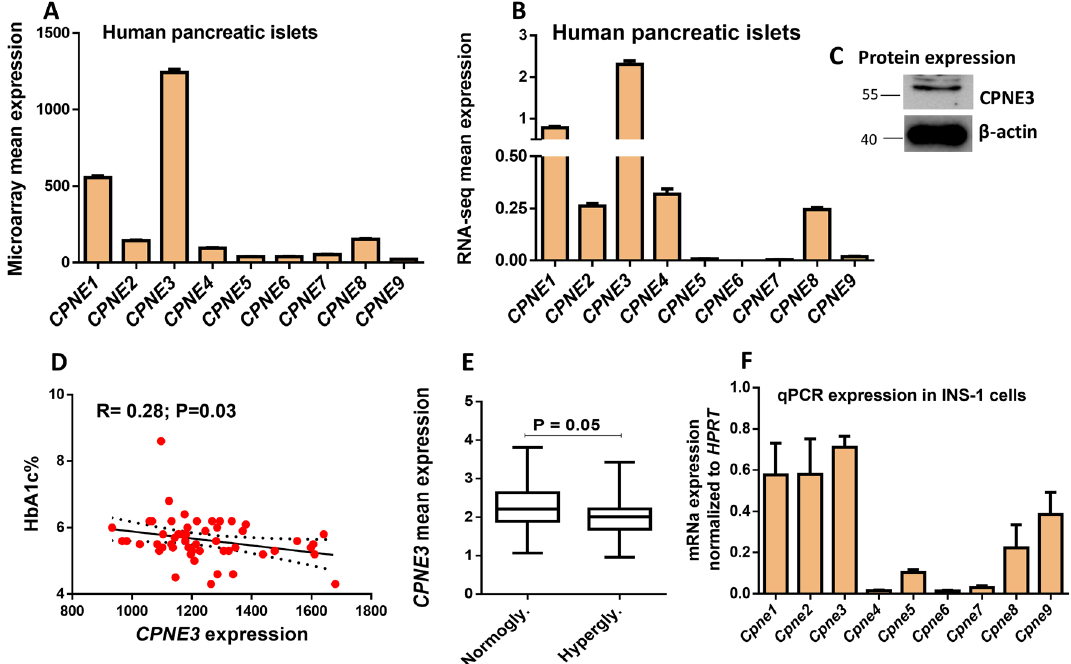
Figure 1. Expression profile of copine genes in human pancreatic islets. ( A ) Microarray mean expression of the nine copine genes in nondiabetic human islets ( n = 67). ( B ) RNA sequencing expression of copine genes in nondiabetic human islets ( n = 67). ( C ) Western blot expression of CPNE3 obtained from nondiabetic human islets (n = 1; obtained from Prodo Lab. Inc, CA., USA). ( D ) Analysis of microarray expression correlation of CPNE3 ( n = 67) with HbA1c levels. R and p-values are indicated in the respective graphs. ( E ) Differential expression analysis of CPNE3 (RNA-seq) in human islets obtained from hyperglycemic donors ( n = 27) vs. human islets from normoglycemic donors ( n = 50). ( F ) q-PCR expression analysis of the nine copine members in INS-1 (832/13) cells. R: correlation coefficient; p: p-value. Bars represent mean ±